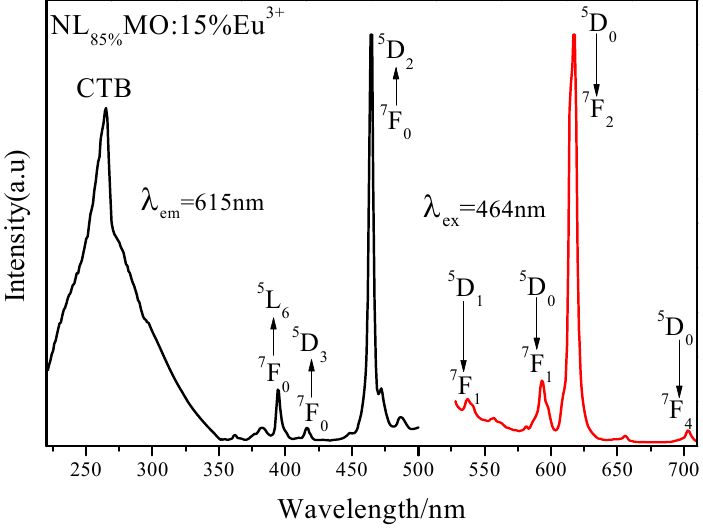
Figure 2. Excitation ( λ em = 615 nm) and emission ( λ ex = 464 nm) spectra of NL 85% MO:15%Eu 3+ .